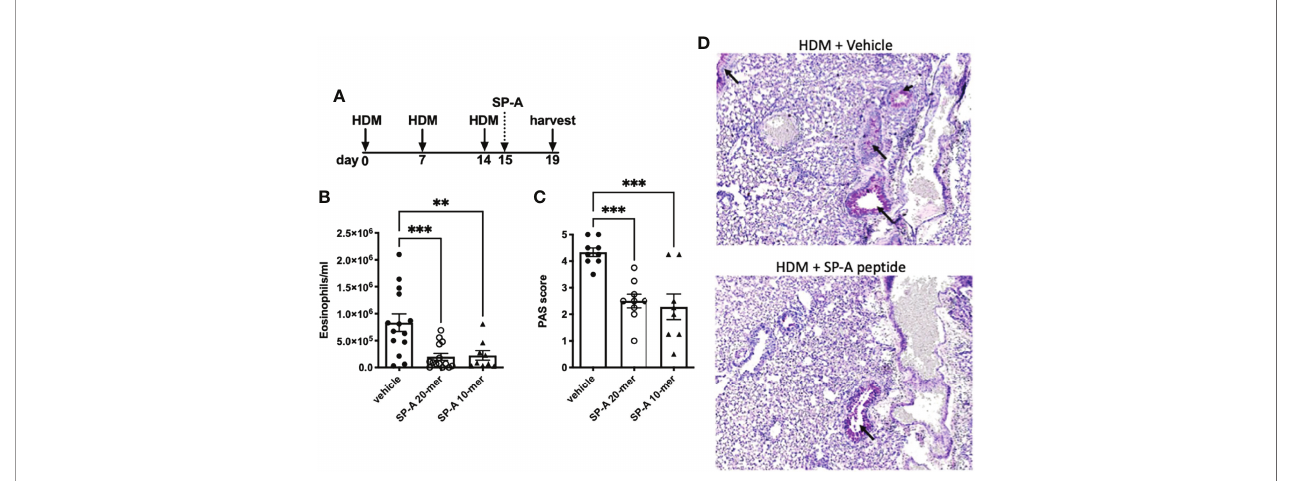
FIGURE 3 | HDM-challenged SP-A de fi cient mice treated with SP-A peptides have reduced hallmarks of in fl ammation. (A) SP-A de fi cient mice challenged intra- nasally with HDM on days 0, 7, and 14. On day 15 mice were divided into groups and given either vehicle or SP-A peptides (10-mer or 20-mer) via oropharyngeal instillation at 25 m g/ml concentration (~1 mg/kg body weight). On day 19, mice were sacri fi ced and (B) eosinophils in the BAL and (C) mucin production in (D) lung histological sections were assessed. n = 10,10, **p < 0.01, ***p < 0.001 by One-way Anova for multiple